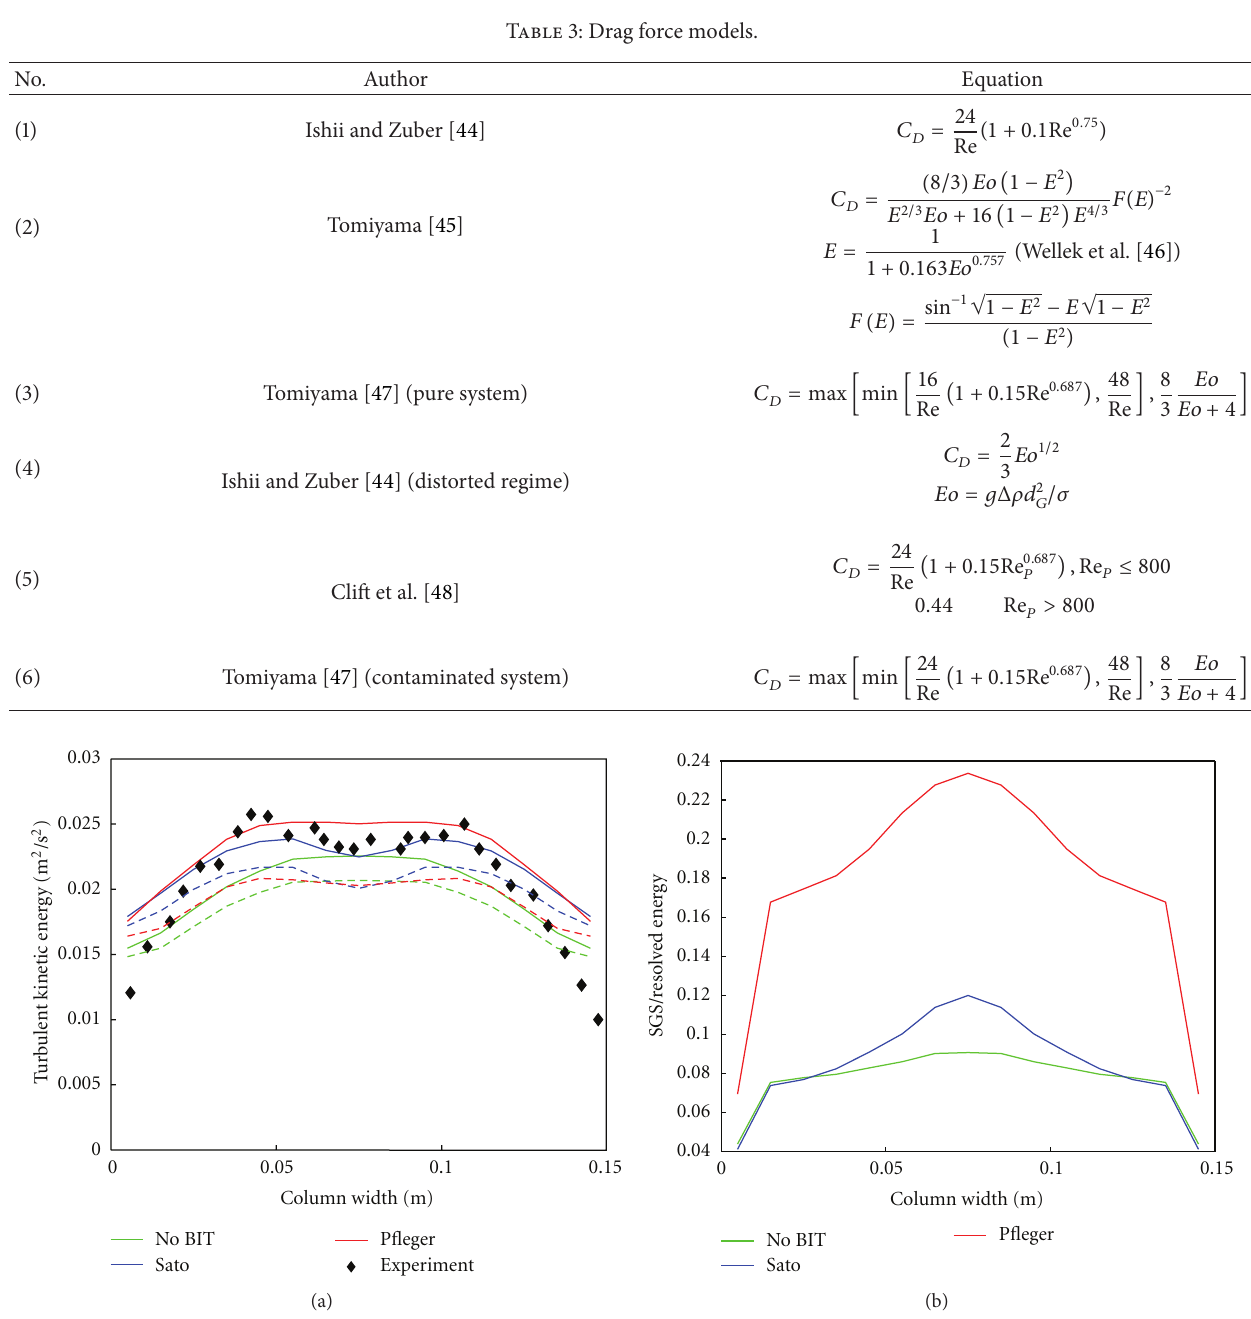
Figure 2: (a) Resolved (dashed) and total (continuous) liquid kinetic energy and (b) ratio of the modelled and resolved parts of the turbulent kinetic for various BIT models. (from Niceno et al.